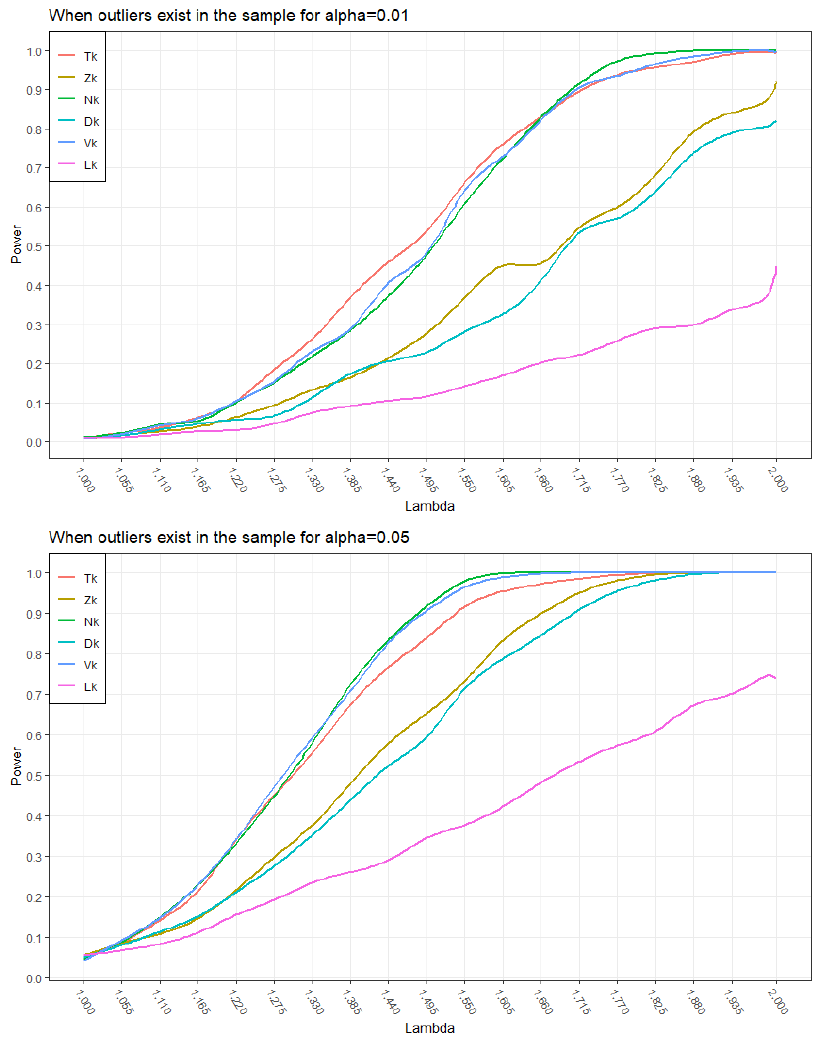
Figure 1. Power of test statistics for m = 5, k = 2, and n =